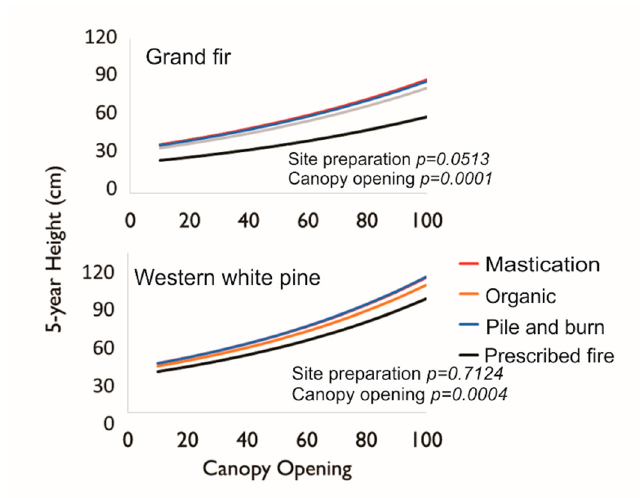
Figure 5. The influence of canopy opening and site preparation on 5-year height growth. Grand fir and western white pine were the only species where growth was influenced (statistically significant) by either canopy opening, site preparation, or both. Western larch (site preparation was p = 0.1492 and canopy opening was p = 0.9338) and Douglas-fir (site preparation was p = 0.2509 and canopy opening was p = 0.1611) 5-year height growth were not related to either.